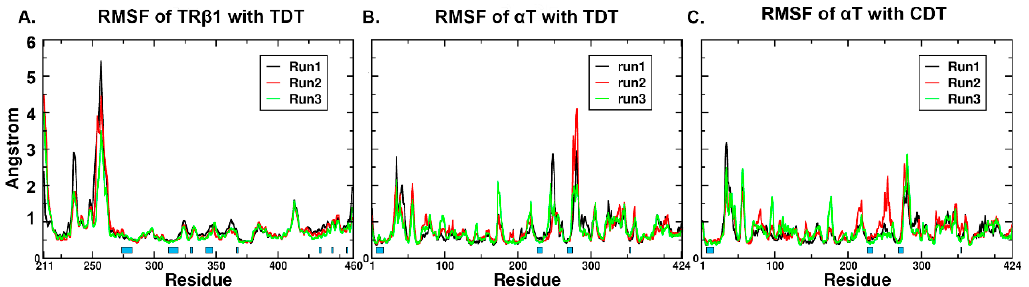
Figure 4. The RMSF of protein backbone atoms in all production phase simulations. The RMSF of backbone atoms in TR β 1-TDT, α T-TDT and α T-CDT system are shown per panel ( A ), ( B ) and ( C ). The residues involved in close contact with ligands (residues within 4.5 Å around the ligands) were marked underneath with blue boxes per panel.